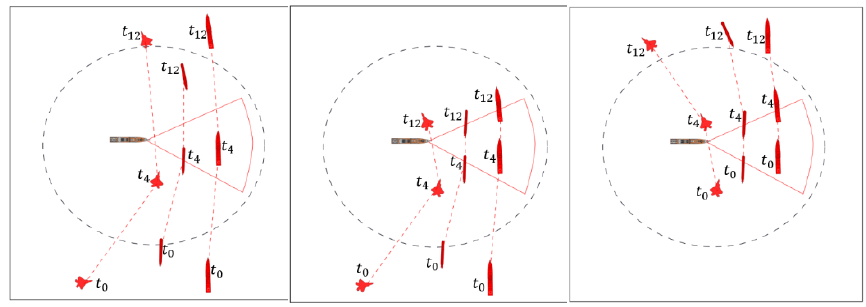
Figure 8. Scenarios of movement patterns of target objects.